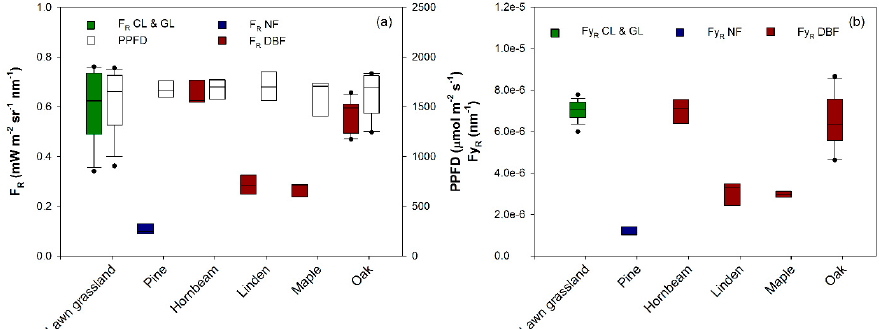
Figure 2. ( a ) Plot of the median, 10th, 25th, 75th and 90th percentiles as vertical boxes of the F; and ( b ) apparent fluorescence yield in the O 2 -B band for different species. Full bars refer to F and Fy estimation, while empty bars refer to the incident photosynthetic photon flux density (PPFD) expressed in µmol·m − 2 ·s − 1 . The statistics refer to 20 samples for each species. CL: cropland, GL: grassland, NF: Needleleaf Forest, DBF: Deciduous Broadleaf Forest.